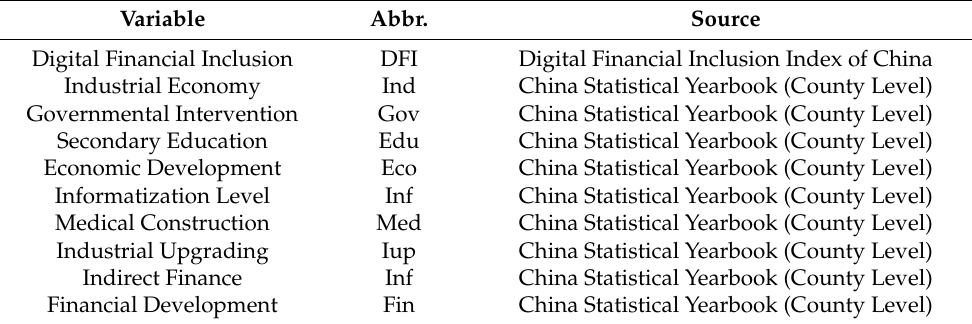
Table 1. Variable data source.